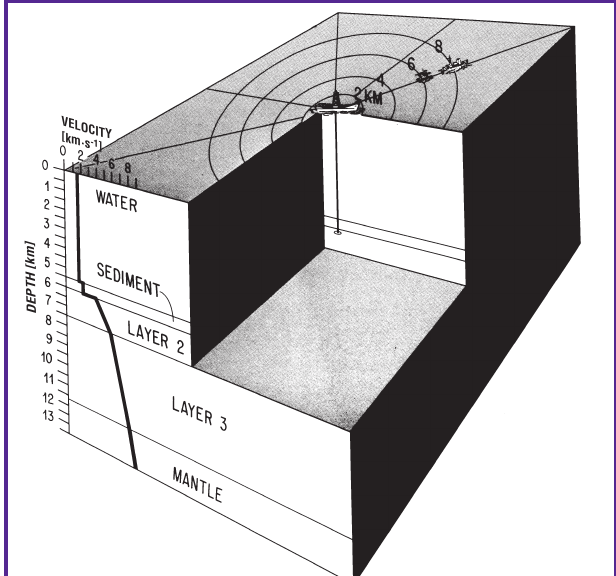
Figure 1. In an Oblique Seismic Experiment the drill ship (top center) maintains its position over the borehole and monitors the downhole geophone while a shooting ship sails concentric circles and radial lines. A generalized oceanic crustal structure and velocity-depth function are shown. The object at 8km is the shooting ship. The object at 6km is intended to represent the splash from a shot in the water (from Little and Stephen,